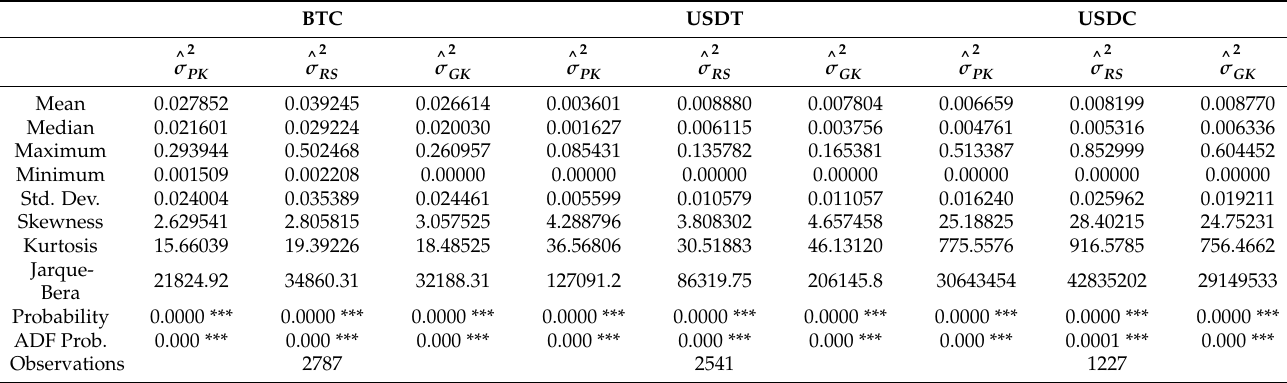
Table 2. Descriptive statistics of range-based volatility